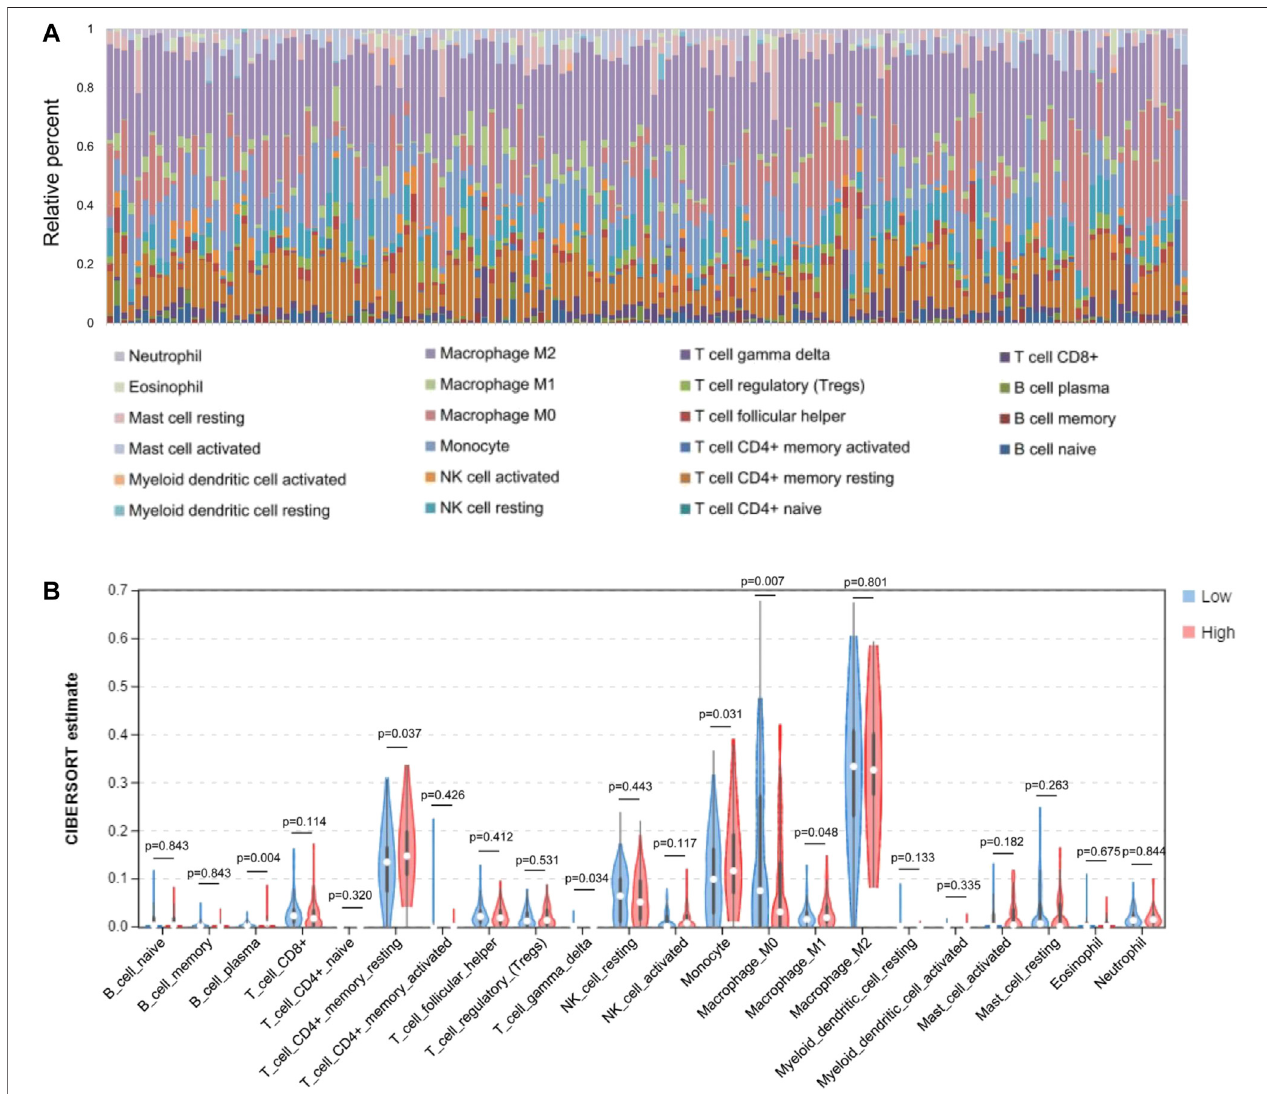
FIGURE 5 | Comparisons of 22 important immune fractions between low- and high-AQL4 groups. (A) The speci fi c 22 immune fractions represented by various colors in each sample were shown in barplot. (B) Wilcoxon rank-sum test revealed that the in fi ltration levels of CD8 + T cell, CD4 + memory resting T cell, M1 and M2 macrophages, as well as dendritic resting cells in high-AQP4 group were lower compared with that in low-AQP4 group.